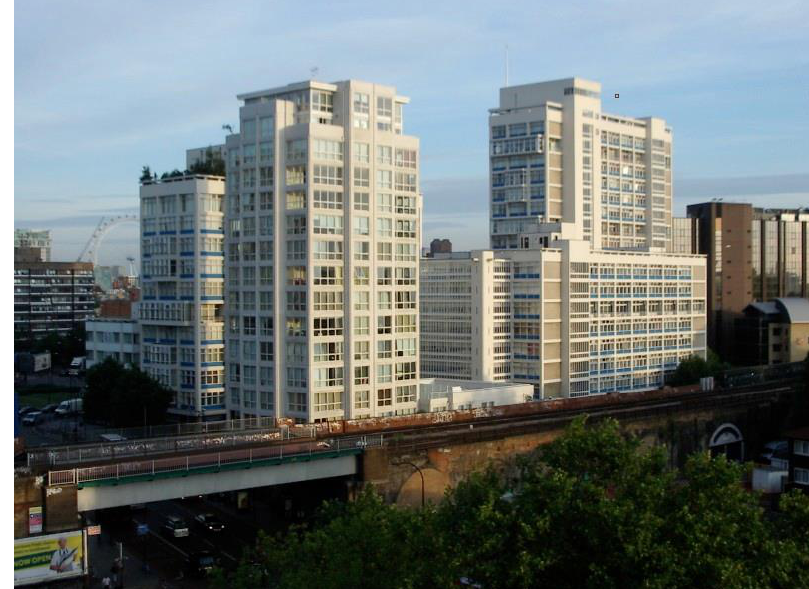
Figure 10. Ministry of Health at Alexander Fleming House in London, 1960–1989. The building was designed by Hungarian architect Erno Goldfinger.